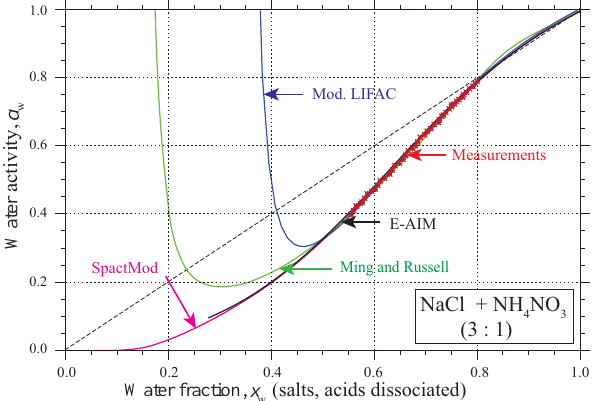
Figure 5. Comparison with measurements of aqueous electrolyte solutions (symbols) and corresponding calculations of the models E-AIM/AIM III (Clegg et al., 1998b), mod. LIFAC (Kiepe et al., 2006), Ming and Russell (Ming and Russell, 2002) and SpactMod at 298K for the salt NaCl + NH 4 NO 3 at a molar salt mixing ratio of (3:1). Note that SpactMod reproduces the results of AIOMFAC (Zuend et al., 2008) due to the same parameters